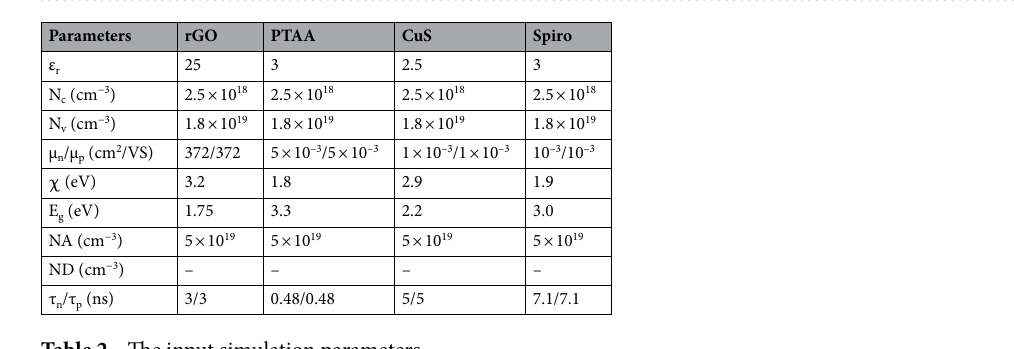
Table 2. The input simulation